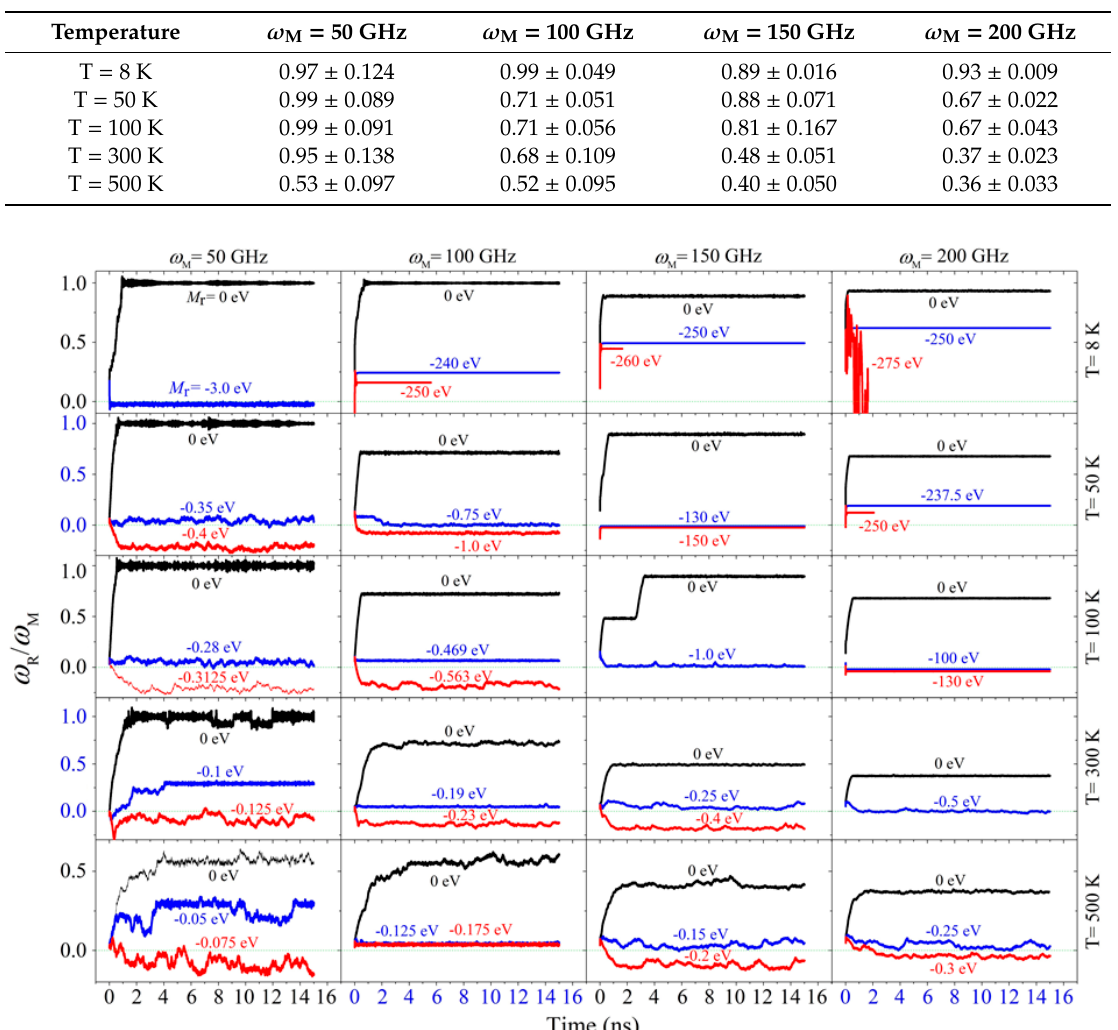
Table 3. Statistical results, i.e., Mean ± Std, of R Tran of the armchair model and subjected to M r = 0 eV (see black lines in Figure 3).